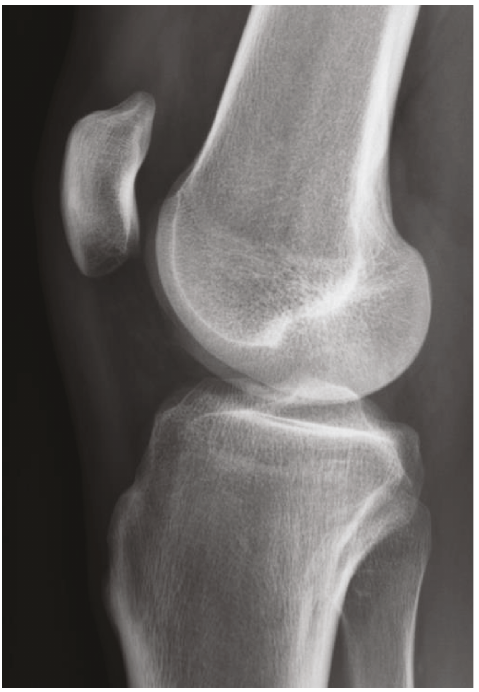
Figure 2: Preoperative X-ray of the contralateral knee to measure the Caton-Deschamps index and patellar